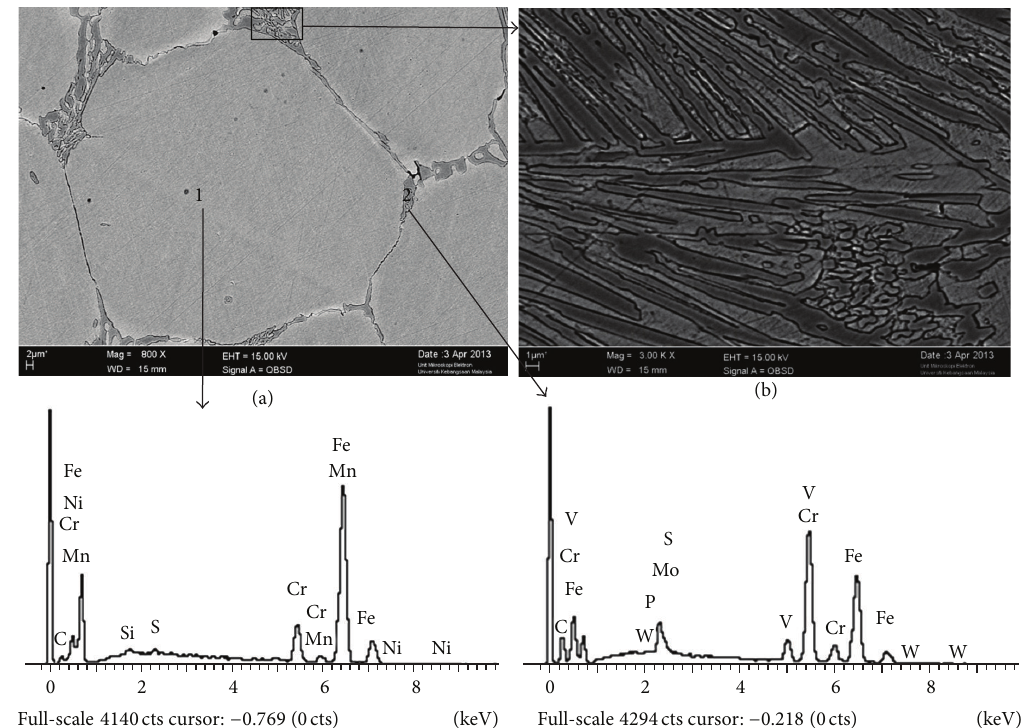
Figure 7: SEM micrographs of AISI D2 sample after being partial remelted at 1300 ∘ C with EDX analysis at points 1 and 2. Note that (b) is the area within the black rectangle shown in (a).